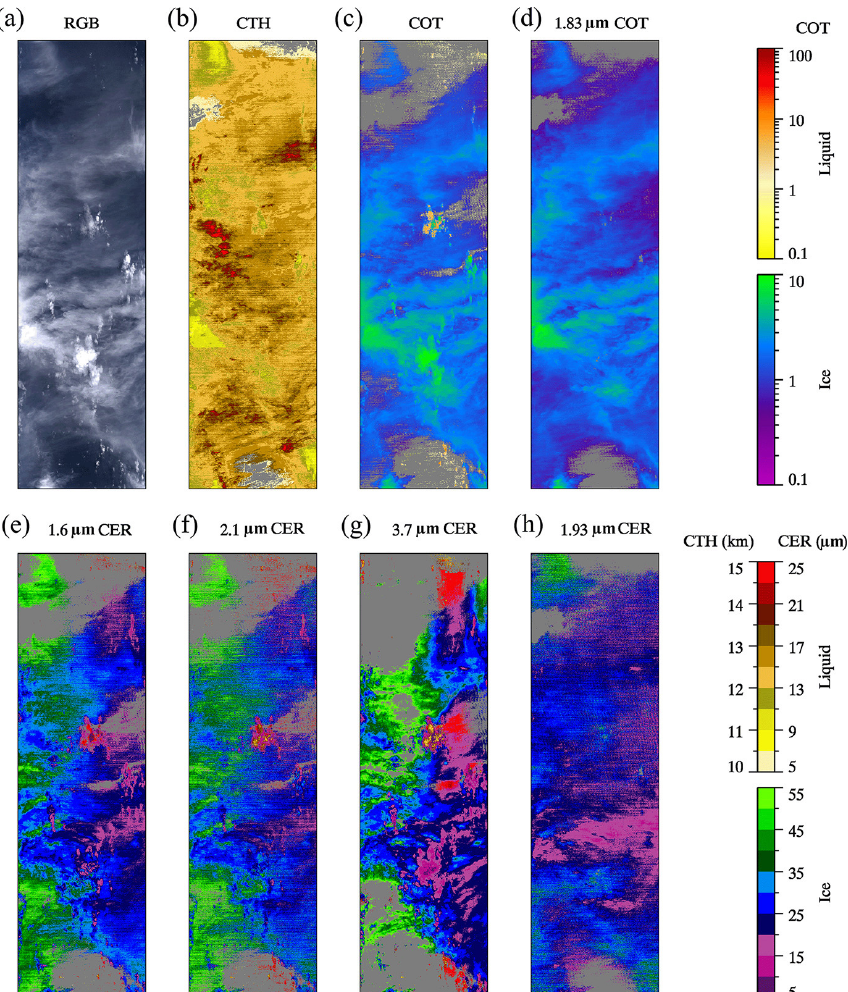
Figure 6. Same as Fig. 4 but for a portion of track 10 of the 18 September 2013 SEAC 4 RS science flight. The direction of travel of the ER-2 is again from top to bottom in each